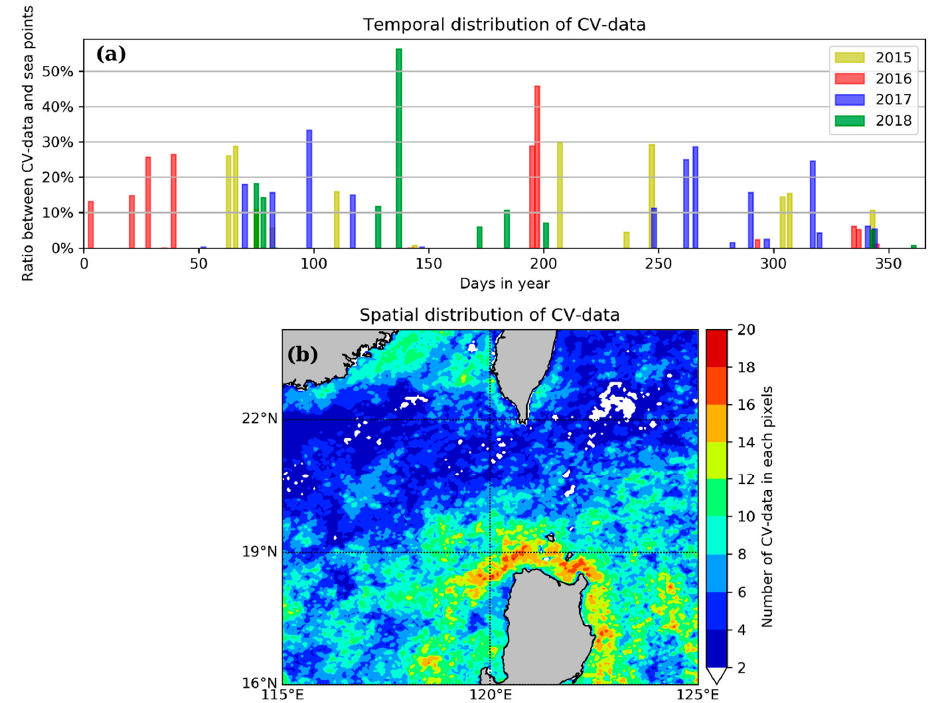
Figure 4. ( a ) Percentages for the temporal distribution of cross-validation data. ( b ) Spatial distribution density of the cross-validation data, where pixels occurring less than twice are marked as white.